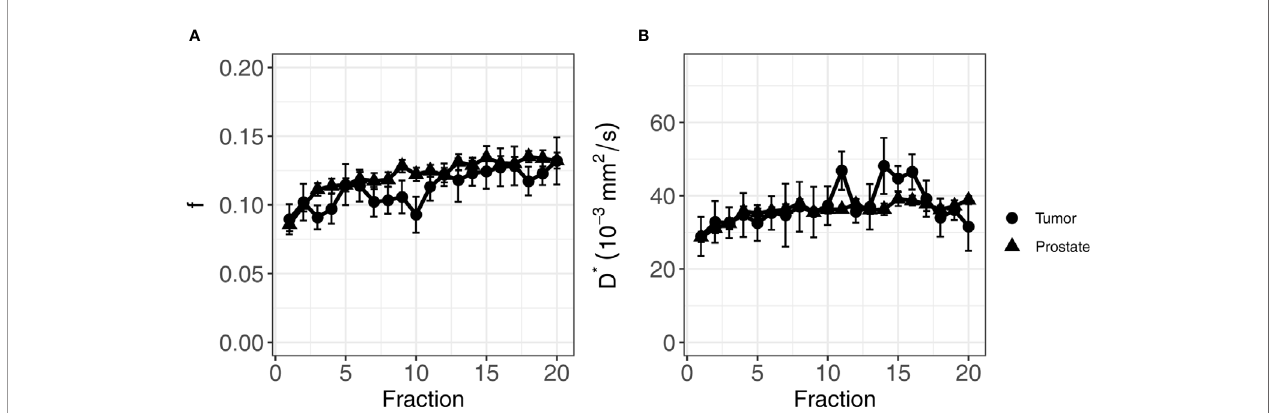
FIGURE 4 | Average of f (A) and D* (B) of all patients over the course of radiotherapy treatment. Error bars indicate the standard error of the mean. Both f and D* increase over the course of treatment in both the tumor and the